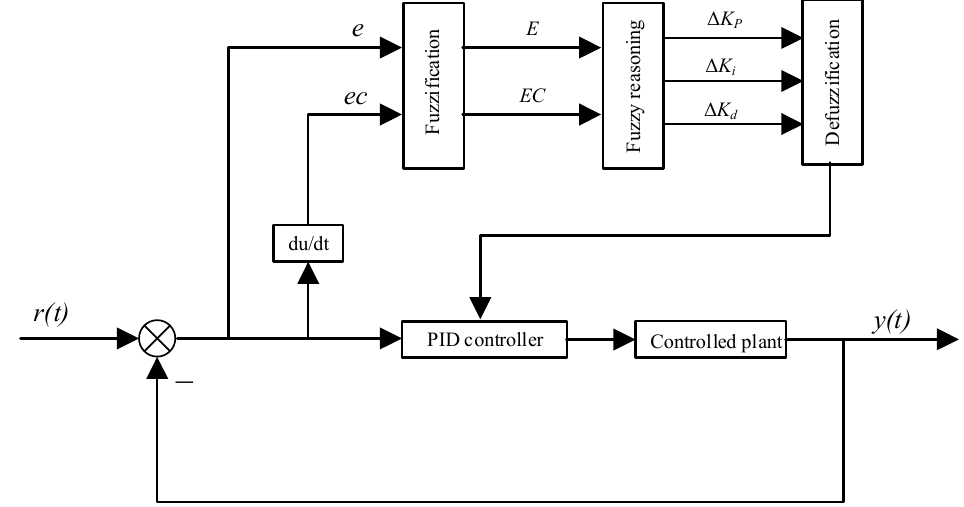
Figure 6. Schematic of Fuzzy-PID control.